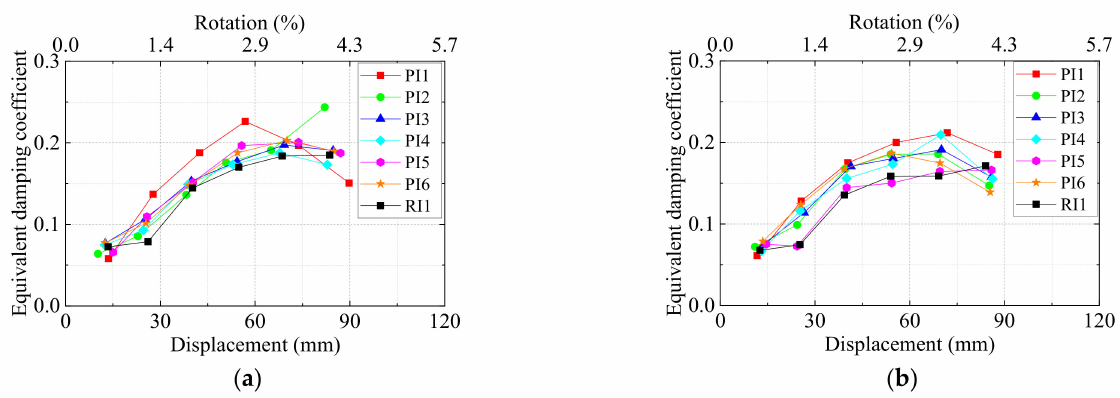
Figure 9. Equivalent damping coefficient. ( a ) Left beams, ( b ) right